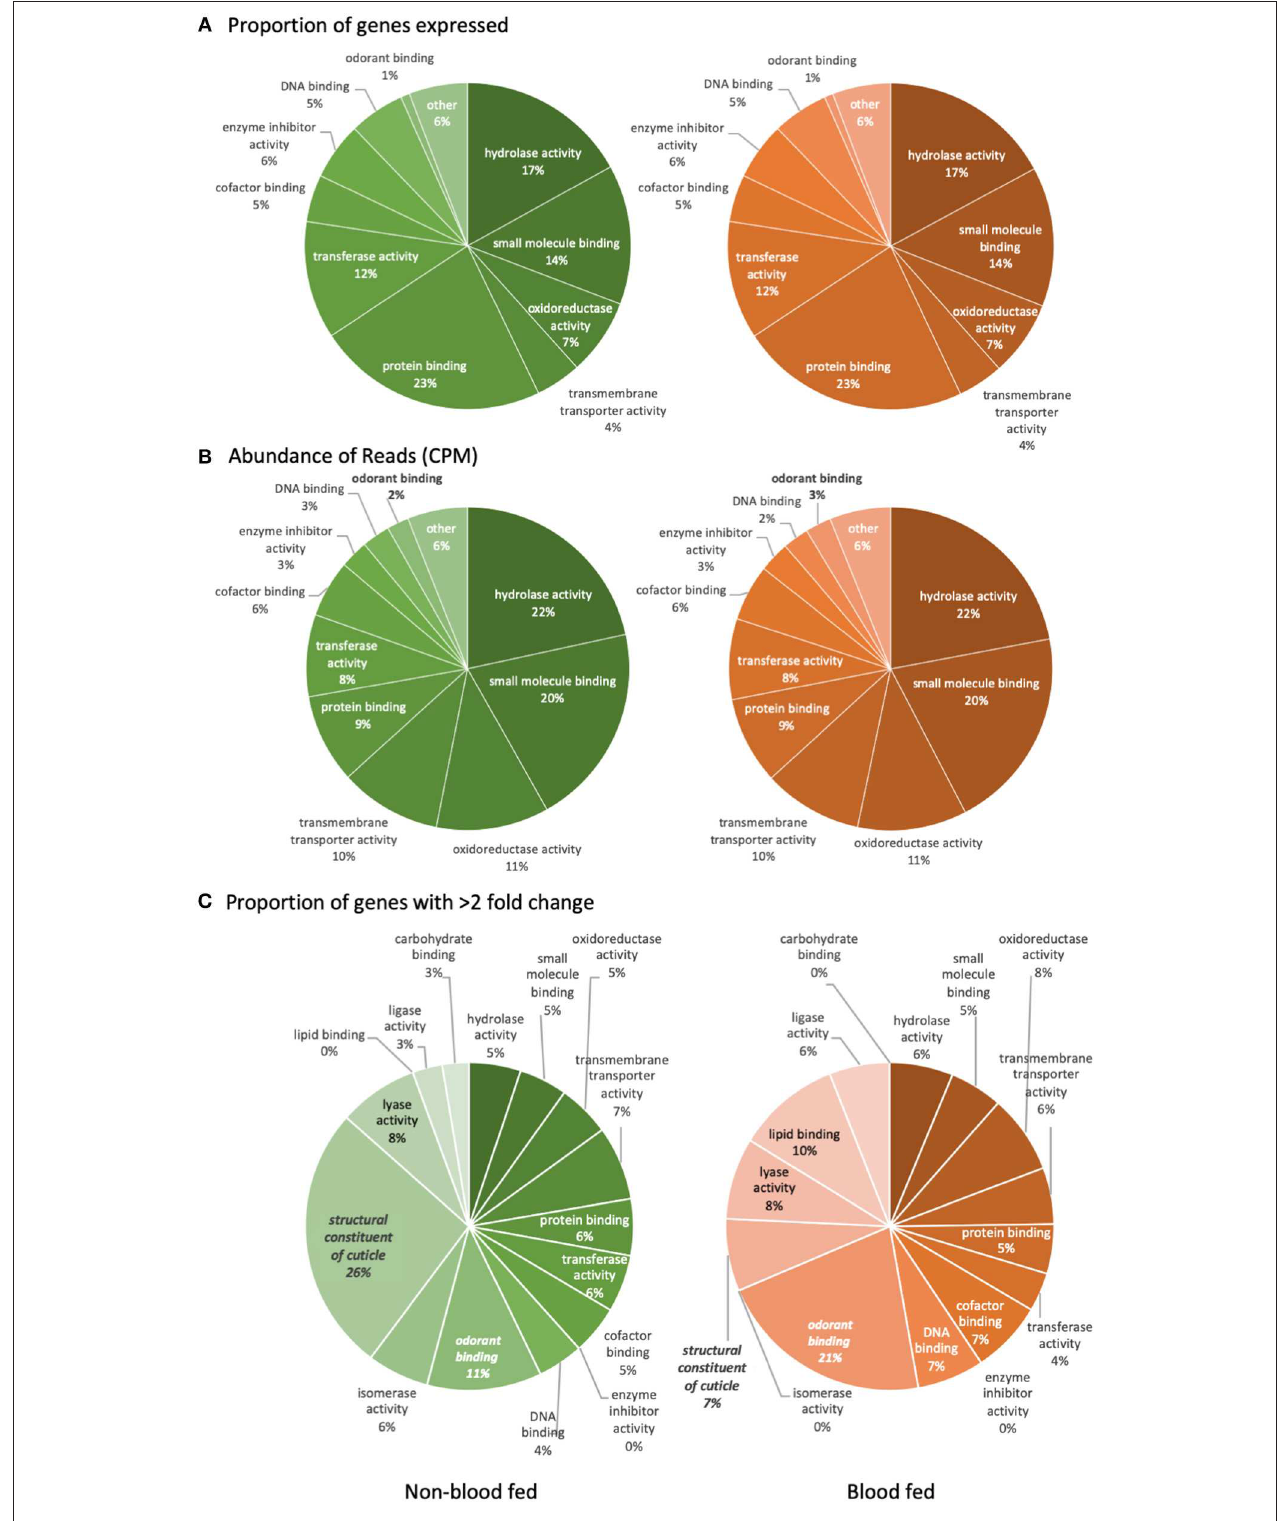
FIGURE 2 | Level three gene ontology analysis of molecular functions. The analysis represents (A) the proportion of reliably expressed genes, (B) the abundance of reads (CPM), and (C) the proportion of genes with > 2-fold change in the maxillary palps transcriptomes of non-blood fed (left) and blood fed (right) female Aedes aegypti . Significant difference (q < 0.05; multiple t -tests) is indicated in bold/italics. Gene ontology classes that were represented by < 1% of the total were not named.